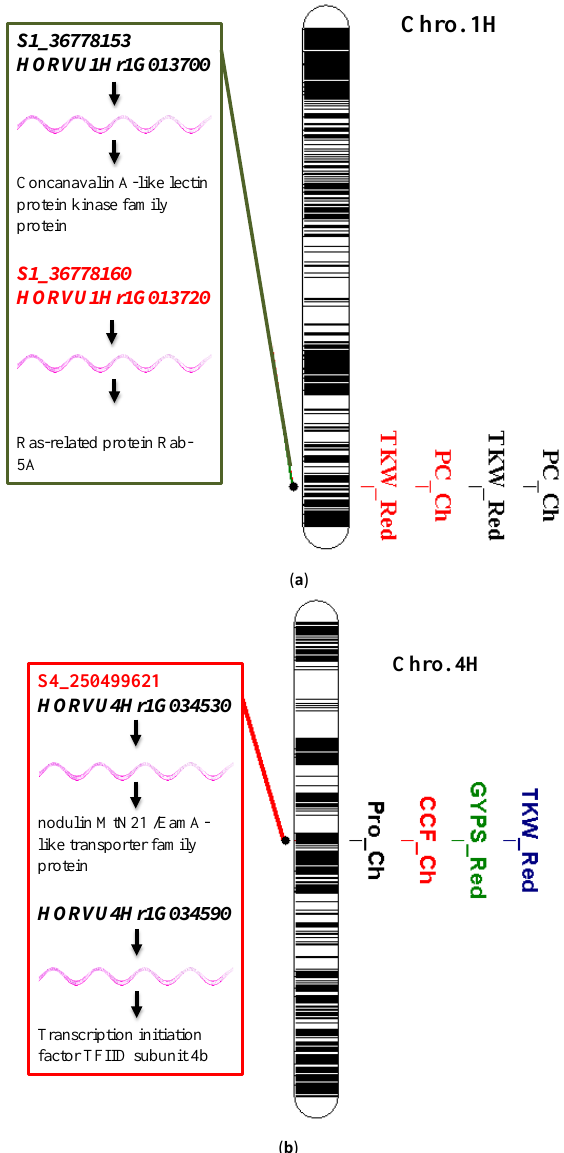
Figure 6. ( a ) Significant single nucleotide polymorphisms (SNPs) associated with changes in protein content (PC) and TKW and their candidate genes; ( b ) significant SNPs associated with the changes in chlorophyll content (CCF) and proline content (Pro), TKW, and GYPS and its candidate genes. Black bands refer to the physical position of the SNP on the respective